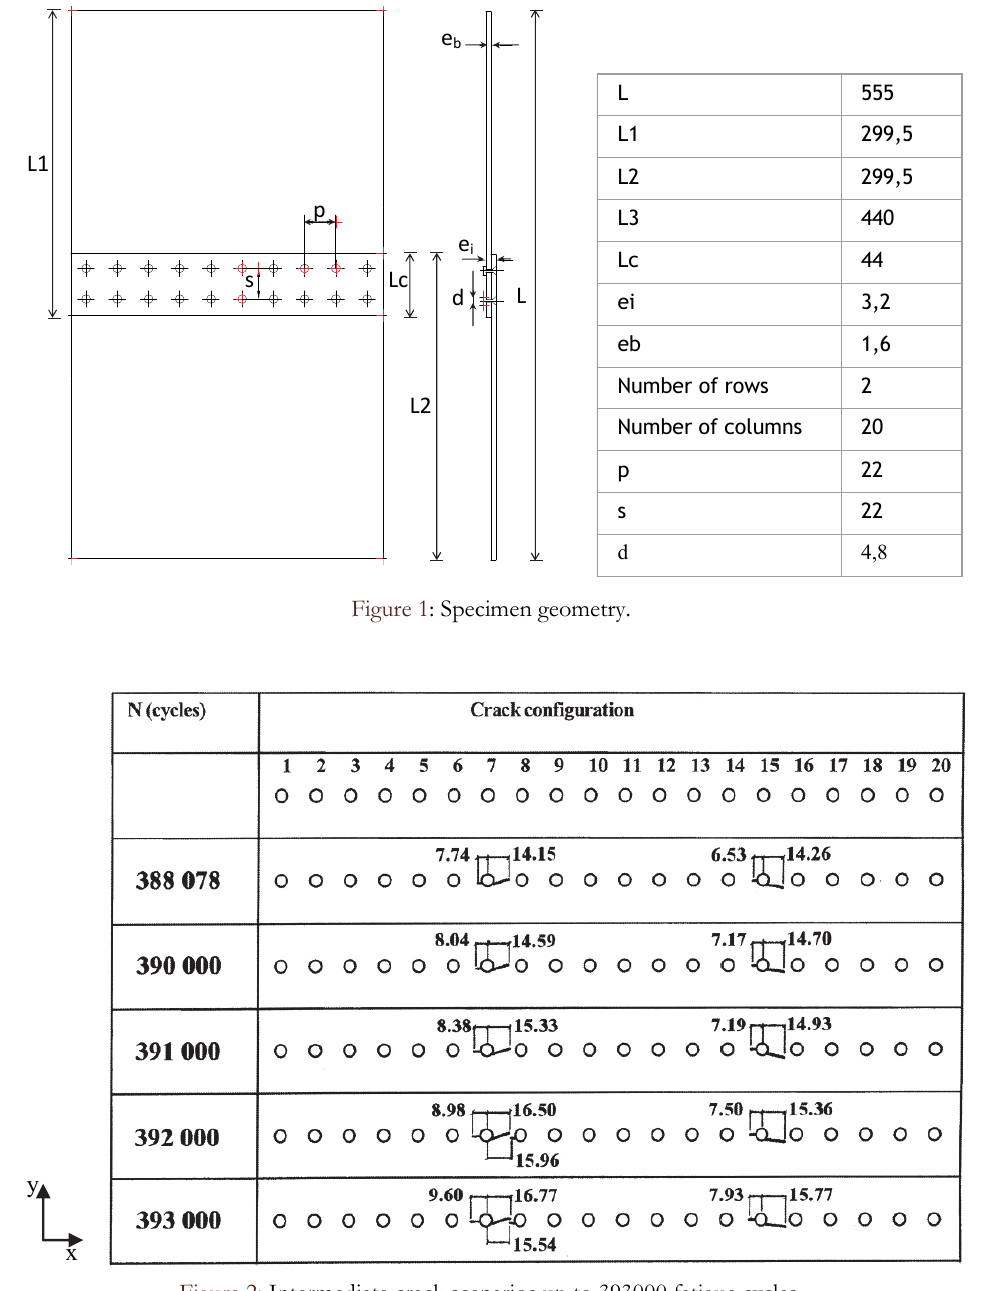
Figure 2: Intermediate crack scenarios up to 393000 fatigue